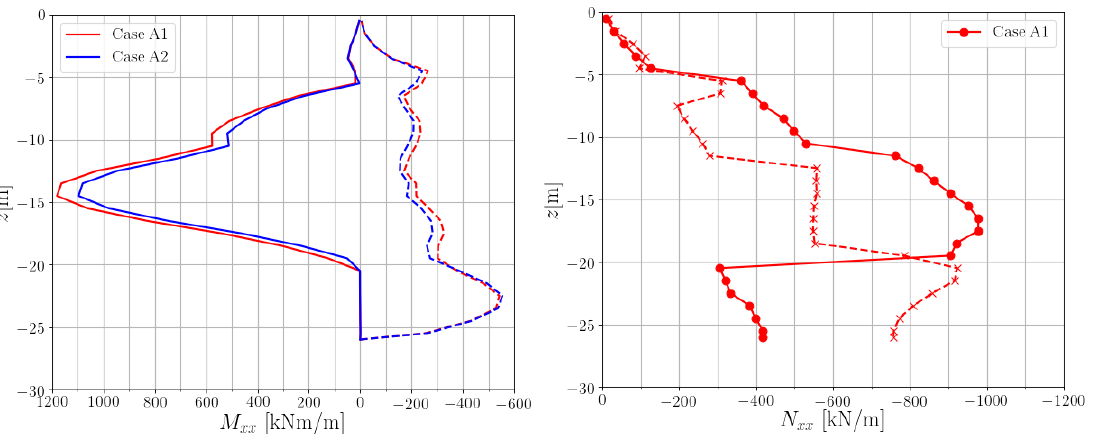
18.75Figure 5: Envelope of characteristic bending moments (Cases A1 and A2) and corresponding membrane forces (Case A1 only) at the time instance when the foundation raft is installed.